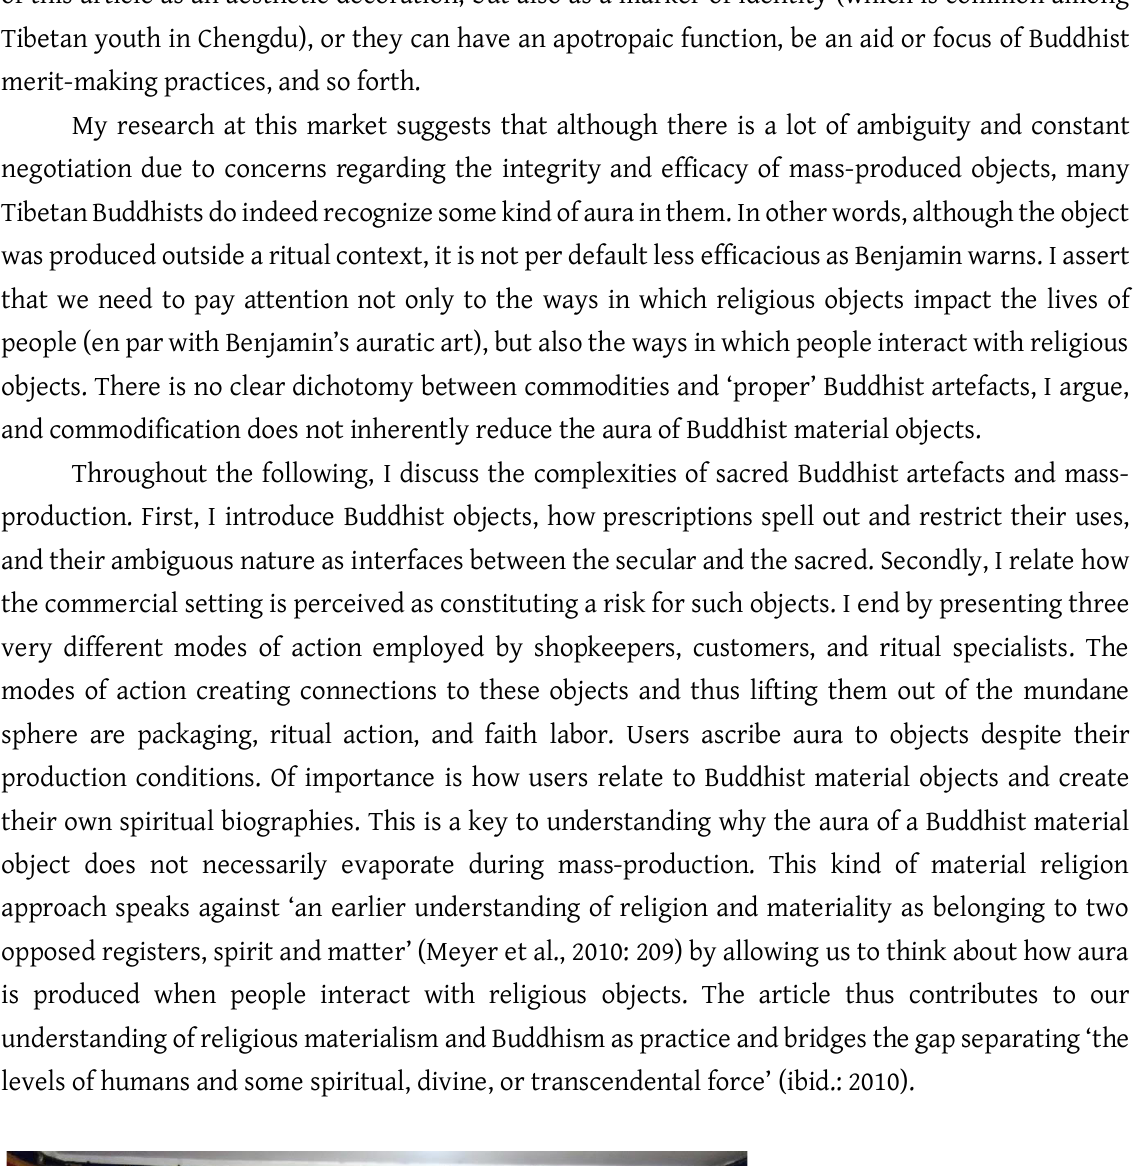
Figure 1. Altar surrounded by commodities in a shop,